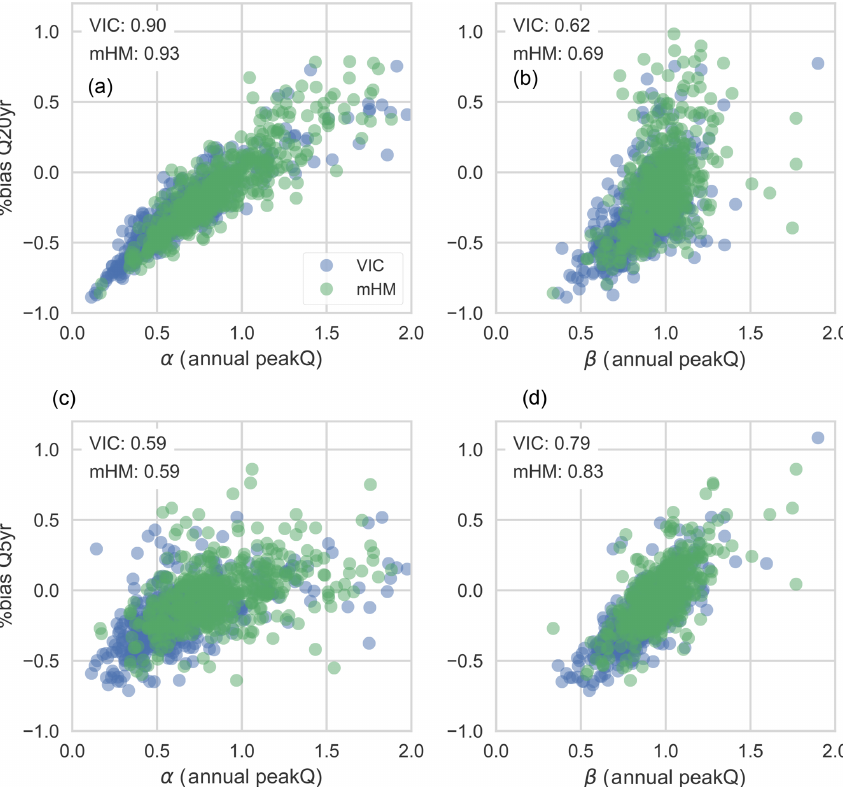
Figure 6. Scatterplots between (a) the simulation–observation ratio of variability of annual peak flow series ( α ) and percent bias of 20-year flood magnitude and (b) the simulation–observation ratio of mean annual peak flow series ( β ) and percent bias of 20-year flood magnitude; (c) and (d) are the same as (a) and (b) except for 5-year flood magnitudes. Linear correlations between two variables are specified in the upper-left corner of each